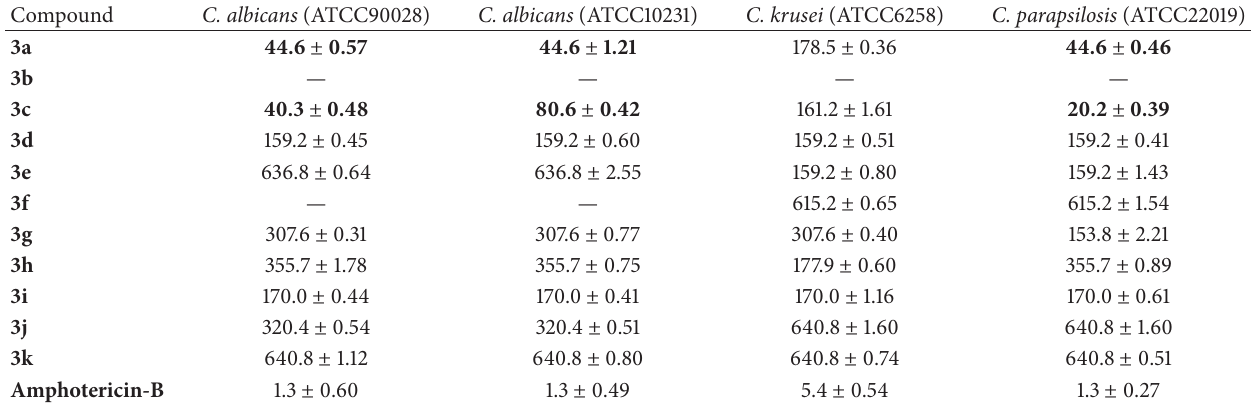
Table 1: Antifungal activity of the synthesised butenediamides (MIC) 𝜇